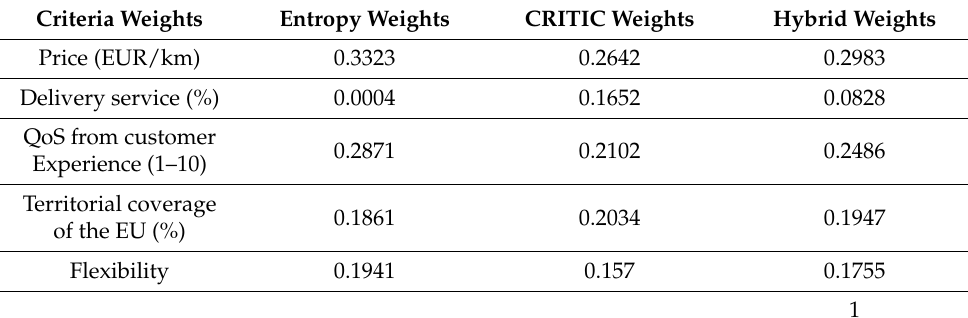
Table 10. Obtained hybrid criteria weights (Source: